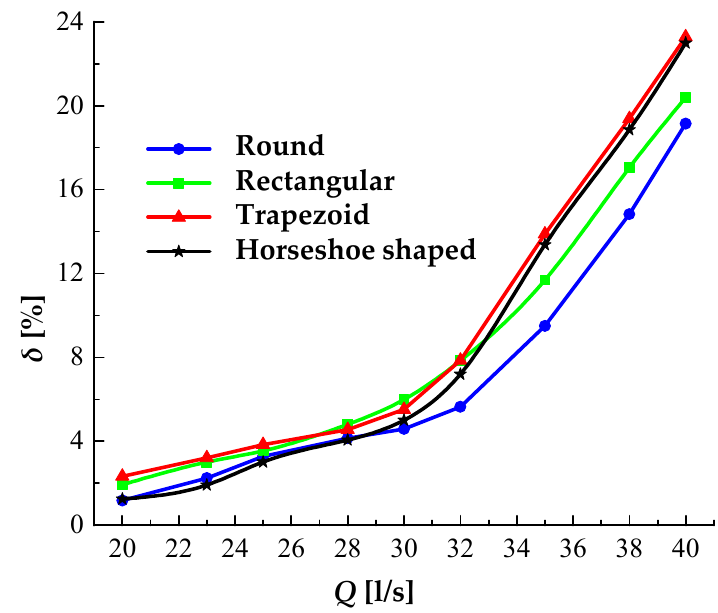
Figure 12. Loss rate of pump with different volutes.